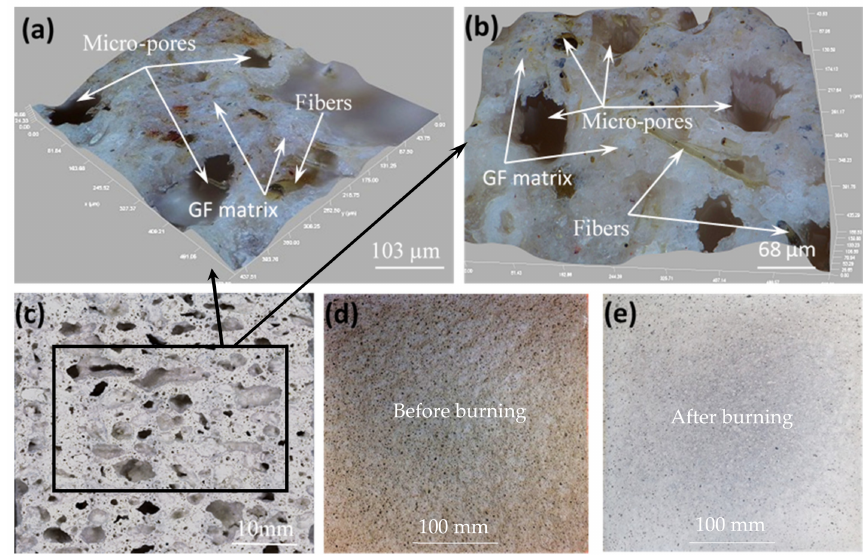
Figure 8. Micrographs and photographs of the GF surface: ( a , d ) before test, ( b , e ) after test and ( c ) cross-section of 40 mm by 40